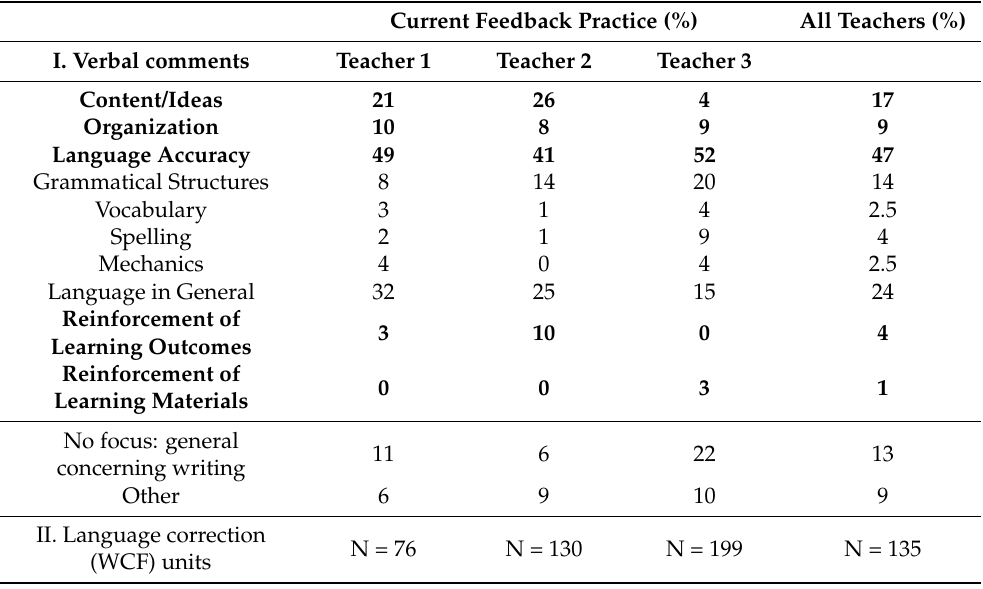
Table 1. Feedback of the focus for all three